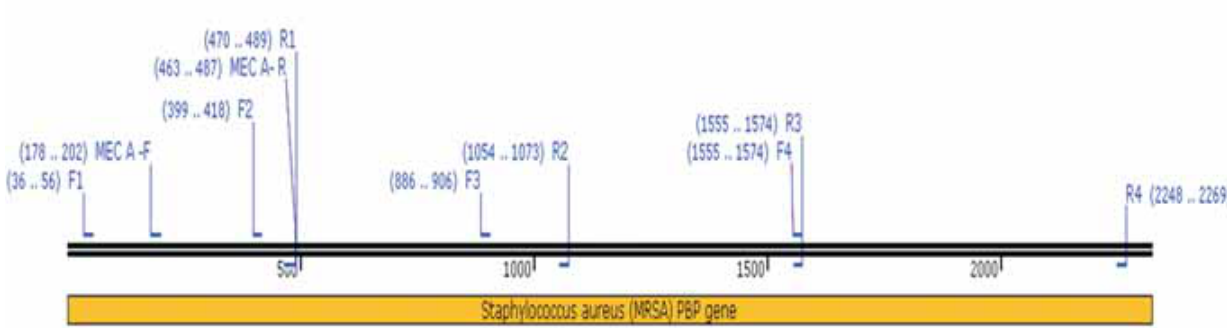
Figure-1: Schematic representation of primer annealing site at gene and the fragment length covered (Developed using SnapGene software).